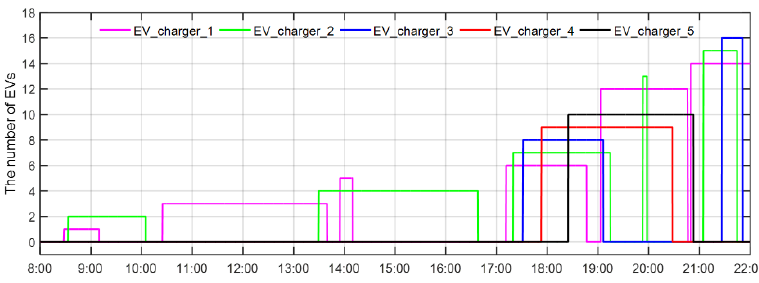
Figure 12. Parking periods of EVs at each charger.